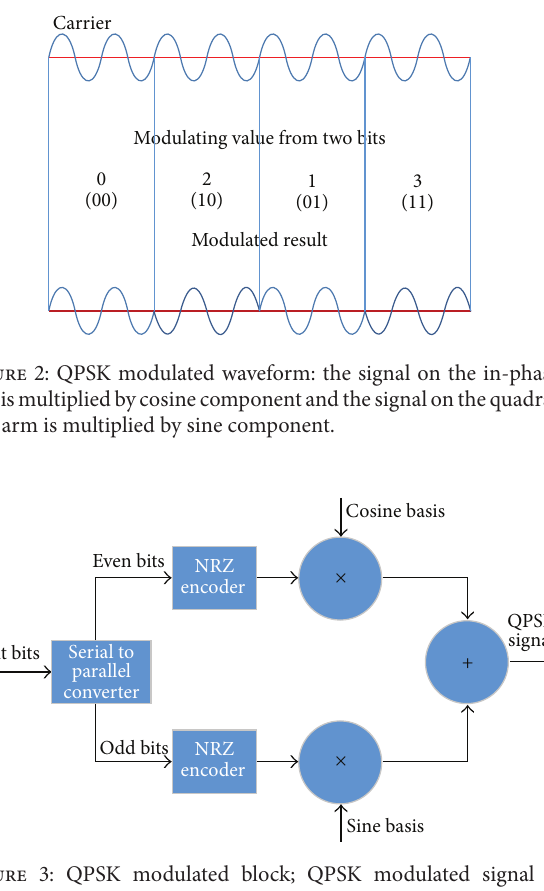
Figure 3: QPSK modulated block; QPSK modulated signal is obtained by adding the signal from both in-phase arm and quadra- ture arm.